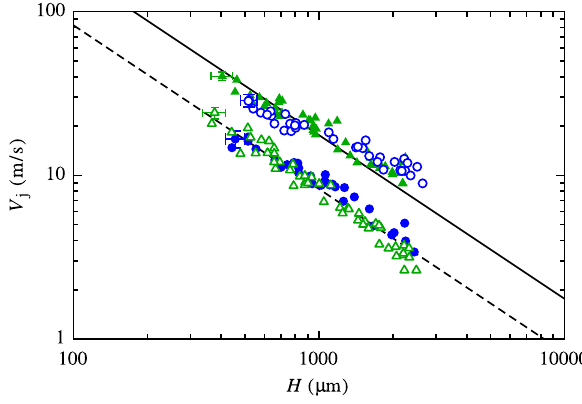
FIG. 7. Asymptotic jet velocity V as a function of the distance j H between the laser spot and the free surface for different capillary diameters and energies. The triangles represent the data for the 200 - (cid:1) m tube at E ¼ 232 (cid:1) J ( m ) and E ¼ 165 (cid:1) J ( 4 ); the circles show the results for the 500 - (cid:1) m tube at E ¼ 458 (cid:1) J ( (cid:7) ) and E ¼ 305 (cid:1) J ( d ). The solid and dashed lines show a (cid:3) 1 power law. Typical error bars are shown for a few data